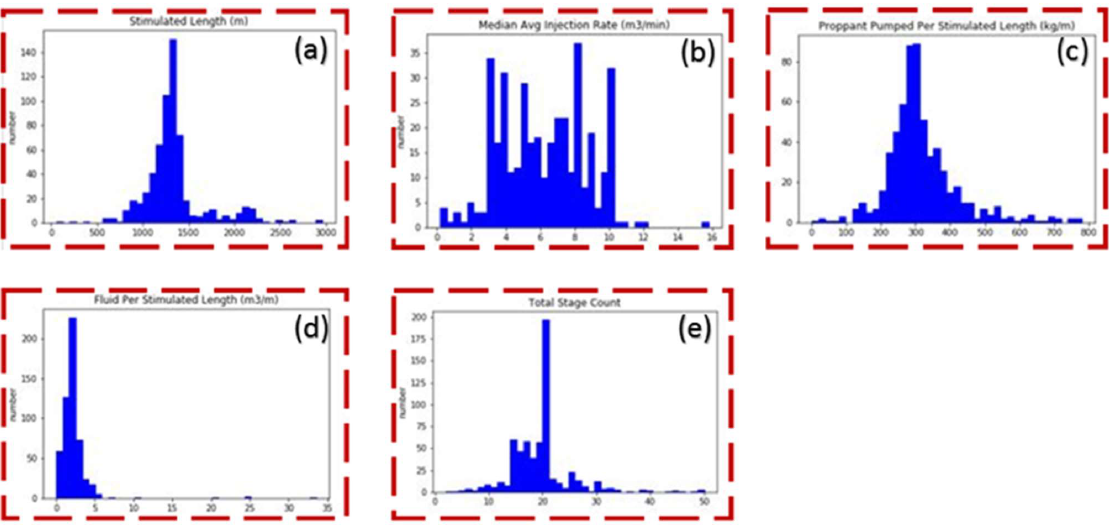
Figure 5. The Wapiti production fields from west to east in unconventional development area.